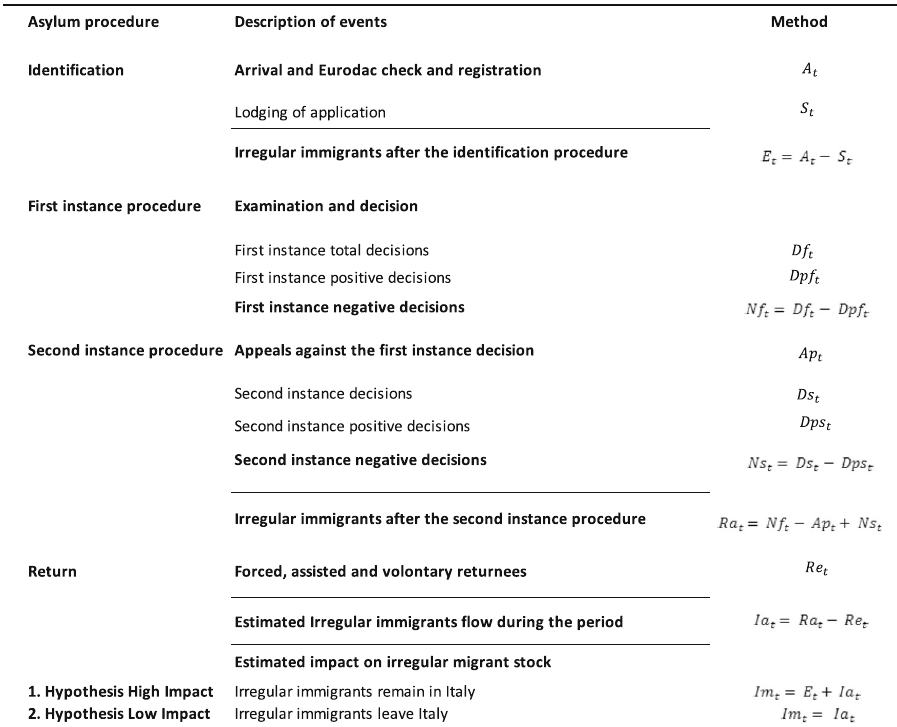
Table 5 Estimation of annual flows linked with asylum procedure,